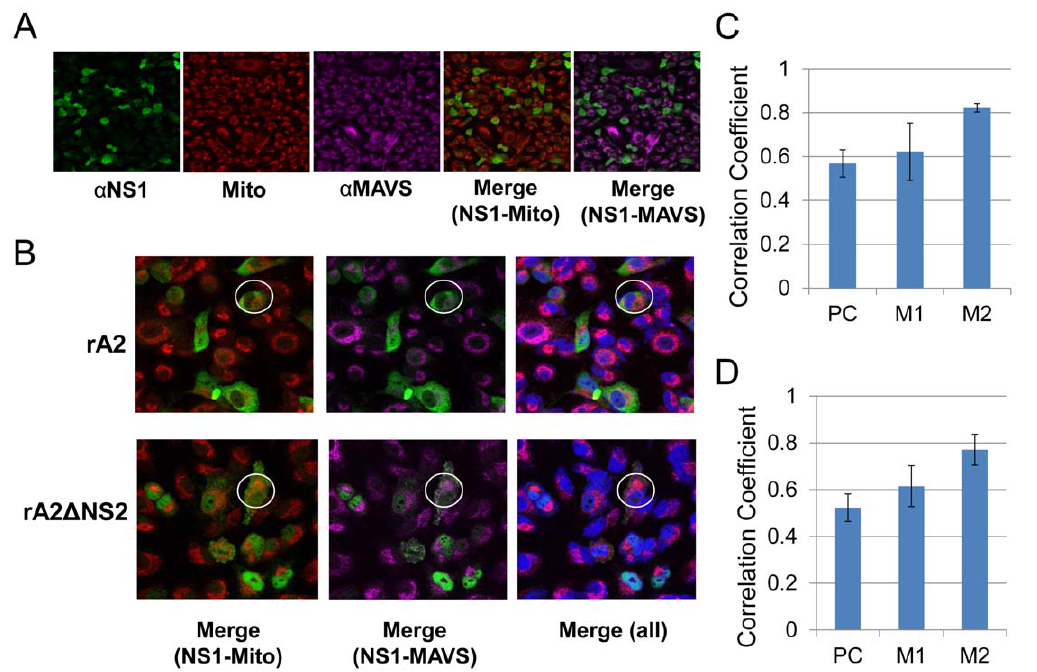
Figure 4. Co-localization of NS1 with MAVS in mitochondria during RSV infection. A549 cells were infected with rA2 or rA2 D NS2 (0.1 MOI).Twelve hours after infection, cells were stained with the mitochondrial stain CMXRos (red). Cells were then fixed and stained with Alexa 488- conjugated anti-NS1 antibody (green) and Alexa 647-conjugated anti-MAVS antibody (purple). Stained cells were viewed under the Leica TCS SP2 laser scanning confocal microscope ( A ) Images (400 6 magnification) show individual staining colors, and merged images of NS1-mitochondria and NS1-MAVS are also shown. ( B ) The images are a 5 6 enlargement of a 400 6 image. The top panel shows the cells infected with rA2 and the bottom panel the cells infected with rA2 D NS2. The areas marked by white circles show the presence of NS1 in mitochondria and colocalization with MAVS. The first pair of images are merges of NS1 and mitochondria. The second pair show NS1 merged with MAVS and the last pair shows all three. ( C ). Correlation analysis of the co-localization of NS1 with mitochondria in rA2 infected cells. ( D ). Correlation analysis of the colocalization of NS1 with mitochondria in rA2 D NS2 infected cells.Pearson’s coefficient for MAVS and NS1 is shown along with Manders’ coefficients (M1 & M2), which represent the fraction of the mitochondrial red overlapping with NS1 green and the fraction of NS1 green overlapping with the mitochondrial red, respectively.